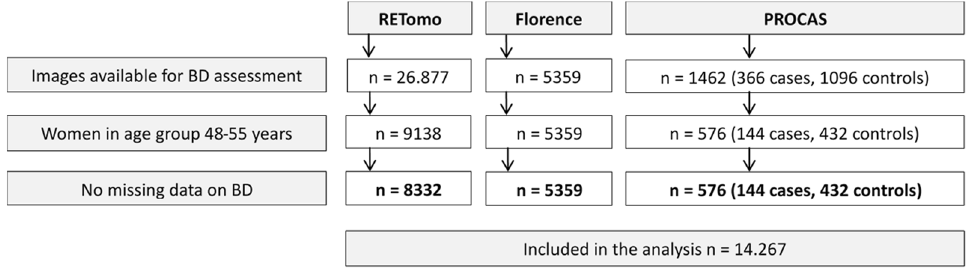
Figure 1. Flowchart of study participants. BD breast density, FFDM fool-field digital